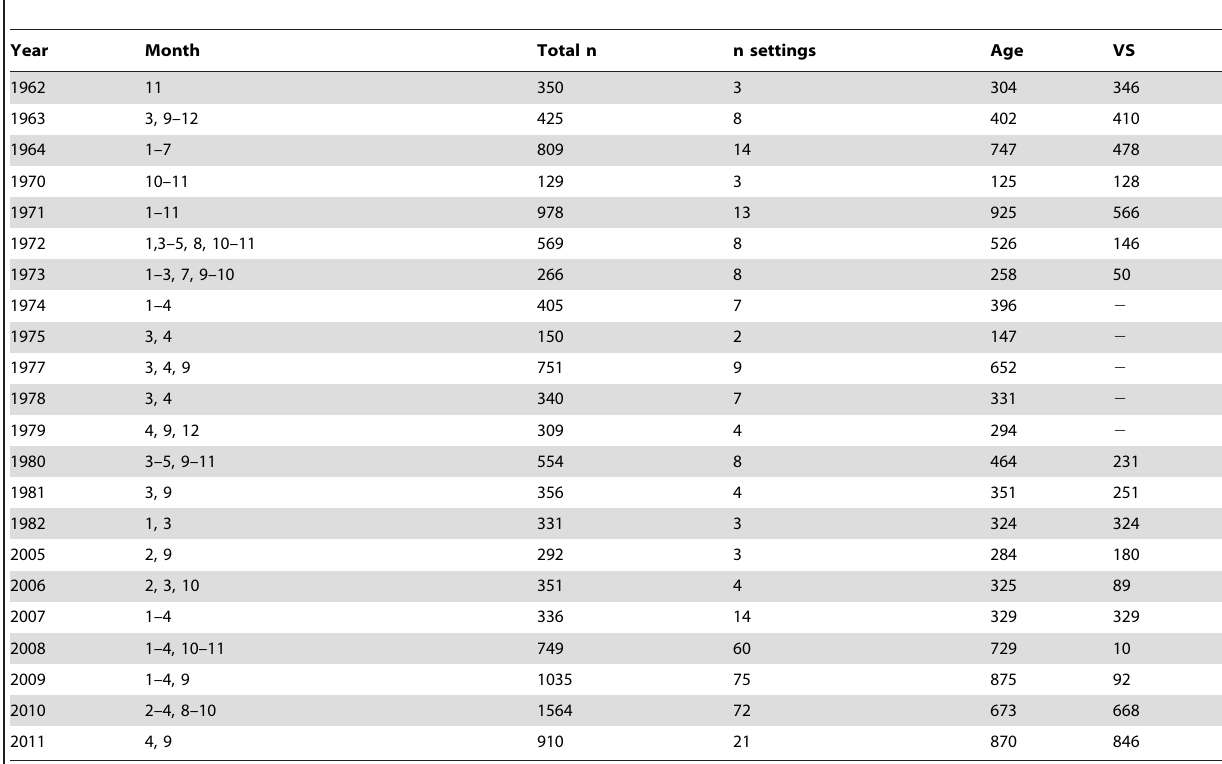
Table 1. Summary information of herring samples from Linda˚spollene 1962–2011, with sampling month, total number of fish analysed (Total n), number of gillnet settings (n settings; referring to single gillnets from 2008 onwards and series of attached gillnets prior to 2008), number of fish sampled for age determination (Age) and